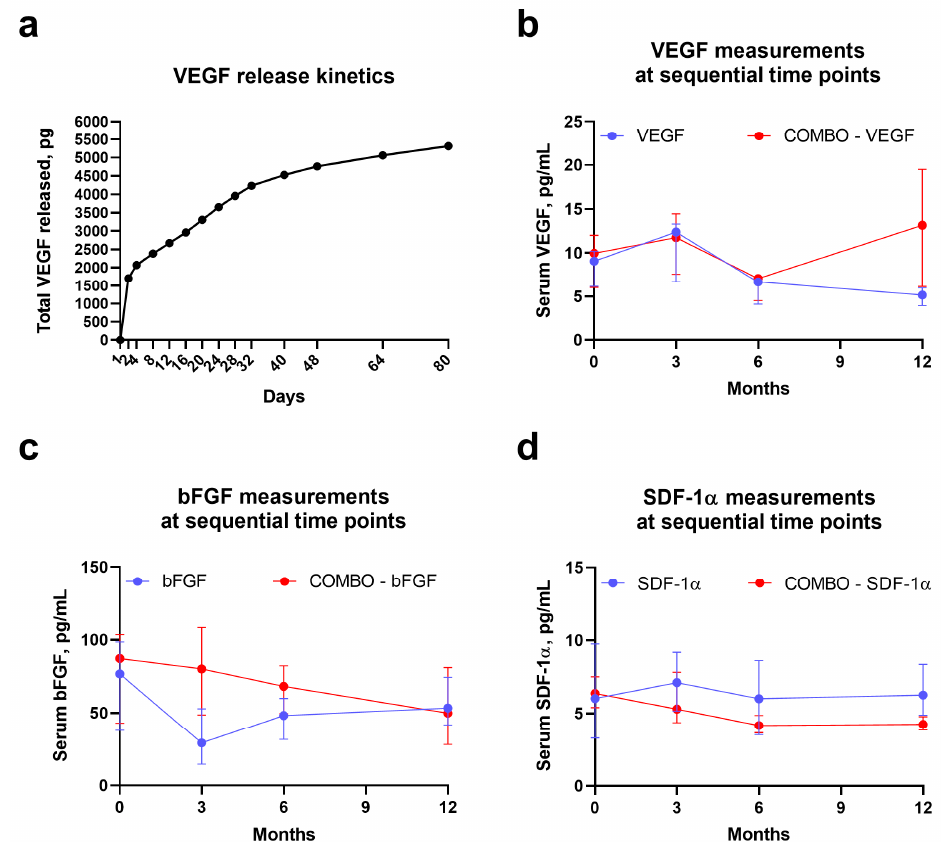
Figure 3. PHBV/PCL vascular grafts ensure sustained and controlled release of bioactive factors. ( a ) Evaluation of in vitro kinetics of VEGF release by incubation of the scaffolds in phosphate-buffered saline and subsequent enzyme-linked immunosorbent assay of the sequentially collected milieu; Quantitative analysis of temporal changes in VEGF ( b ), bFGF ( c ), and SDF-1 α ( d ) in the serum of Wistar rats which underwent the implantation of the grafts into the abdominal aorta for the indicated time points. Note an increase in VEGF upon 3 months of the implantation and superior kinetics profile of two-layer grafts with all three bioactive factors incorporated. Blue dots and lines indicate the values from the animals with the grafts containing VEGF, bFGF, or SDF-1 α alone. Red dots and lines indicate the values from the animals which underwent implantation of the grafts with all three bioactive factors combined